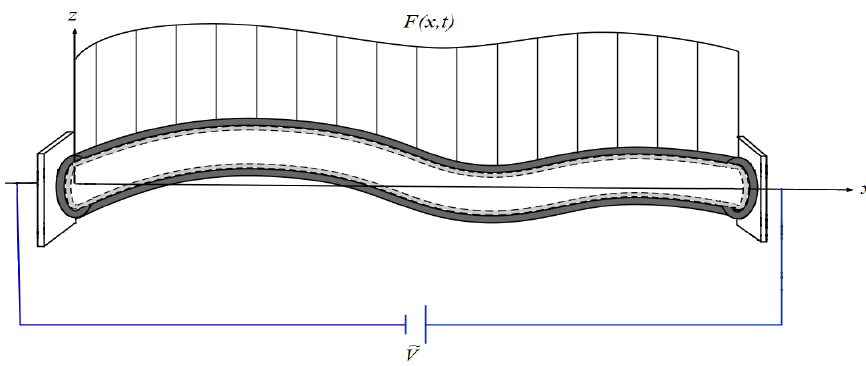
Figure 1. Schematic model of the curved nanotube with slender piezoelectric layer.